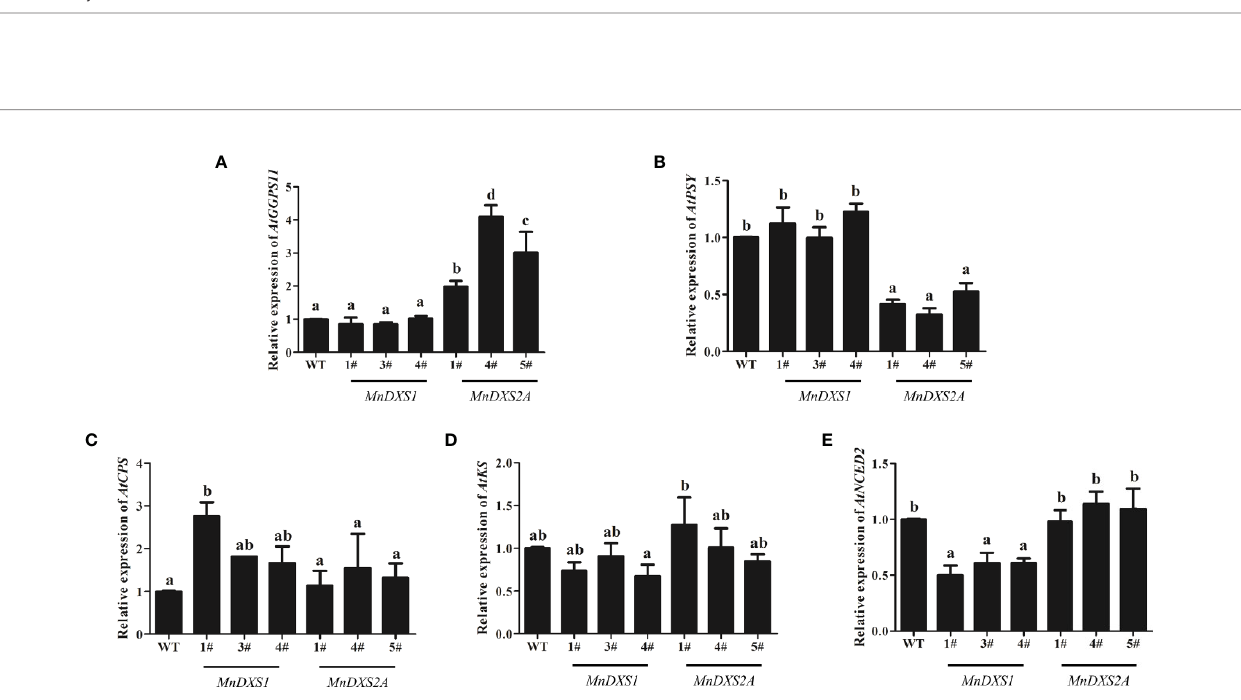
FIGURE 7 | Relative expression levels of biosynthesis-related genes- geranyl (geranyl) diphosphate synthase 11 (GGPPS11) for chlorophyll synthesis (A) , phytoene synthase (PSY) for carotenoid synthesis (B) , ent-copalyl diphosphate synthase (CPS) and entkaurene synthase (KS) for GA synthesis (C, D) , and nine-cis- epoxycarotenoid dioxygenase 2 (NCED2) for ABA synthesis (E) in WT plants and MnDXS1 -, MnDXS2A -overexpressing transgenic lines. The Actin2 gene was used as the internal control to normalize the expression levels. Data are presented as the mean ± standard error of the mean of three replicates. Different letters above bars represent signi fi cant differences (p < 0.05) as determined with the one-way Duncan ’ s